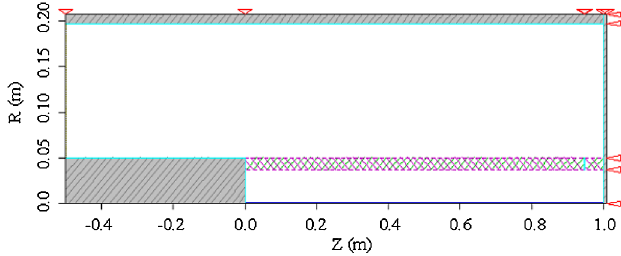
FIG. 9. (Color) A schematic of thin tube water load.